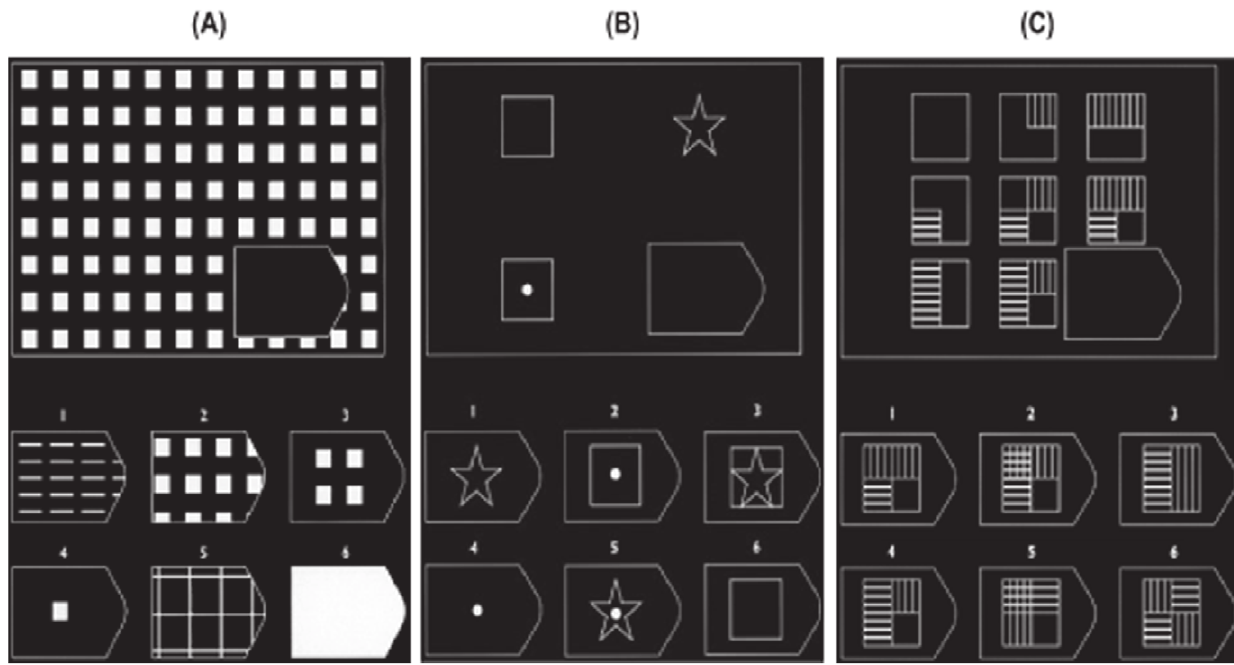
Figure 2. Sample stimuli for the Raven’s Progressive Matrices problems. (A) ‘‘Figural’’ condition, (B) ‘‘easy analytic’’ condition, and (C) ‘‘difficult analytic’’ condition. Participants were asked to select one out of the six alternatives by pressing a button.